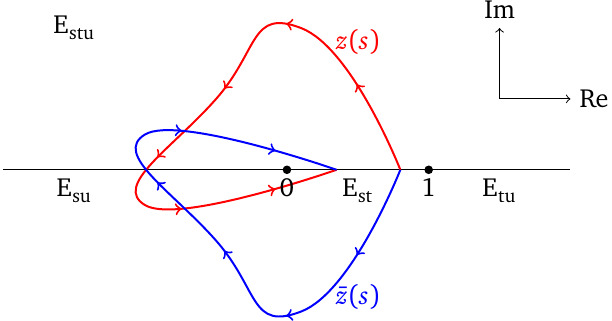
Figure 5.3: An example of z ( s ) , ¯ z ( s ) along γ